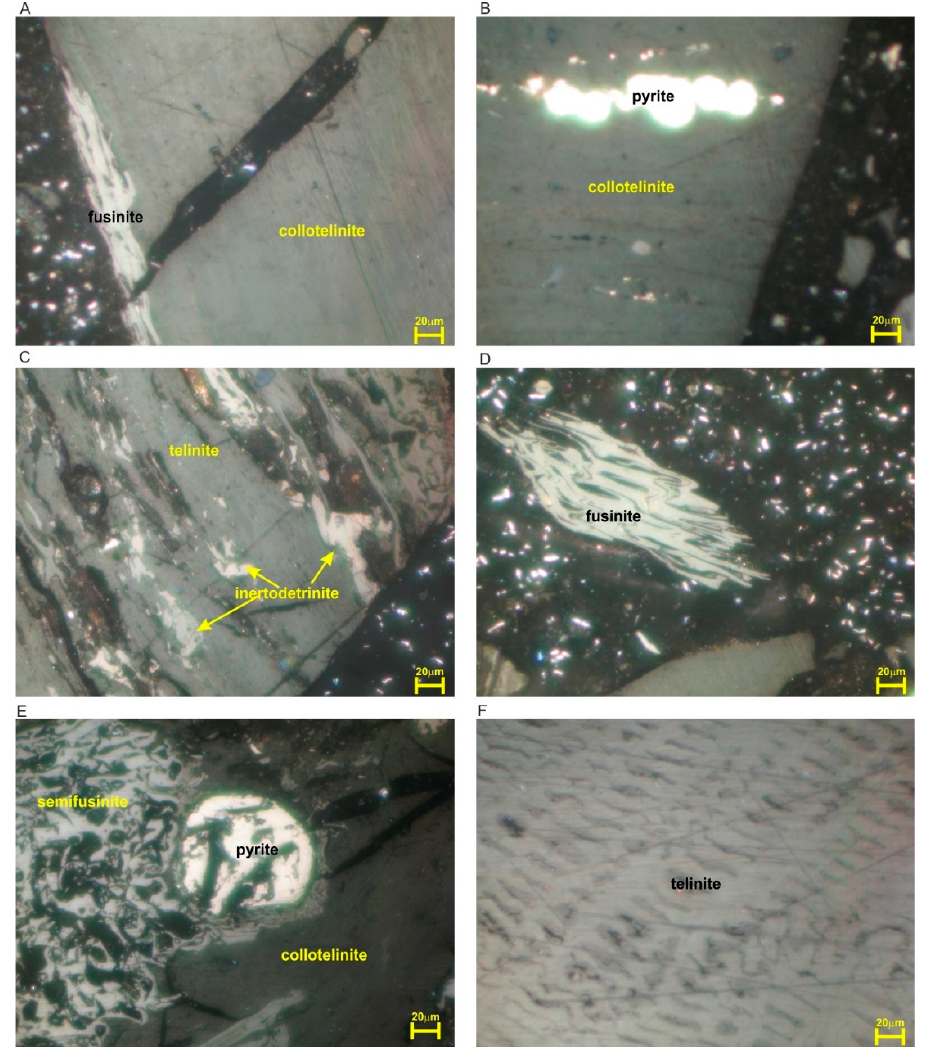
Figure 1. Macerals in coal from the Janina deposit: ( A ) Collotelinite with fusinite (bright), ( B ) collotelinite with framboidal pyrite (light), ( C ) telinite (dark) with inertodetrinite (bright), ( D ) fusinite, ( E ) semifusinite with pyrite and collotelinite (bright), ( F ) telinite. Reflected light, oil immersion.